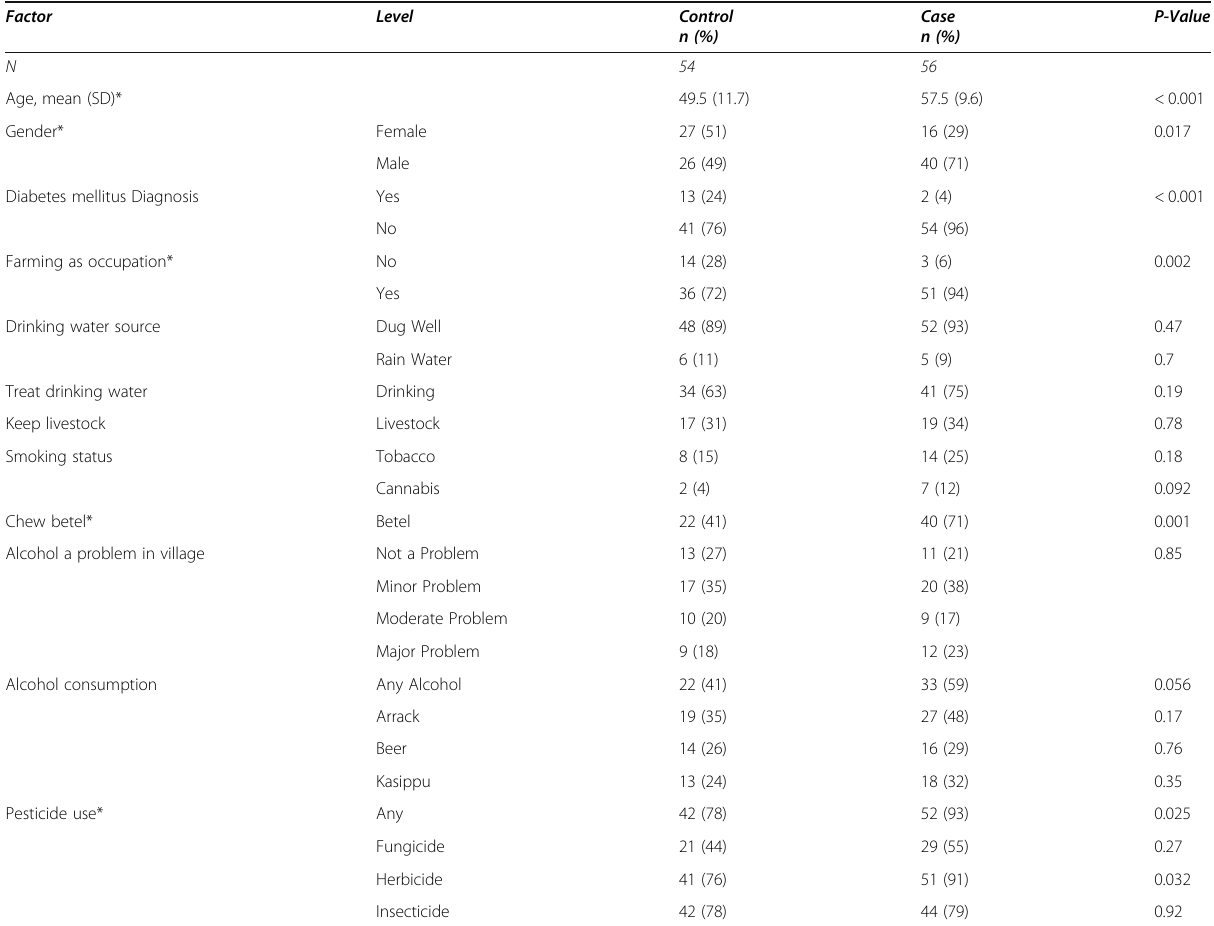
Table 1 Study Population Characteristics by Case-Control Status